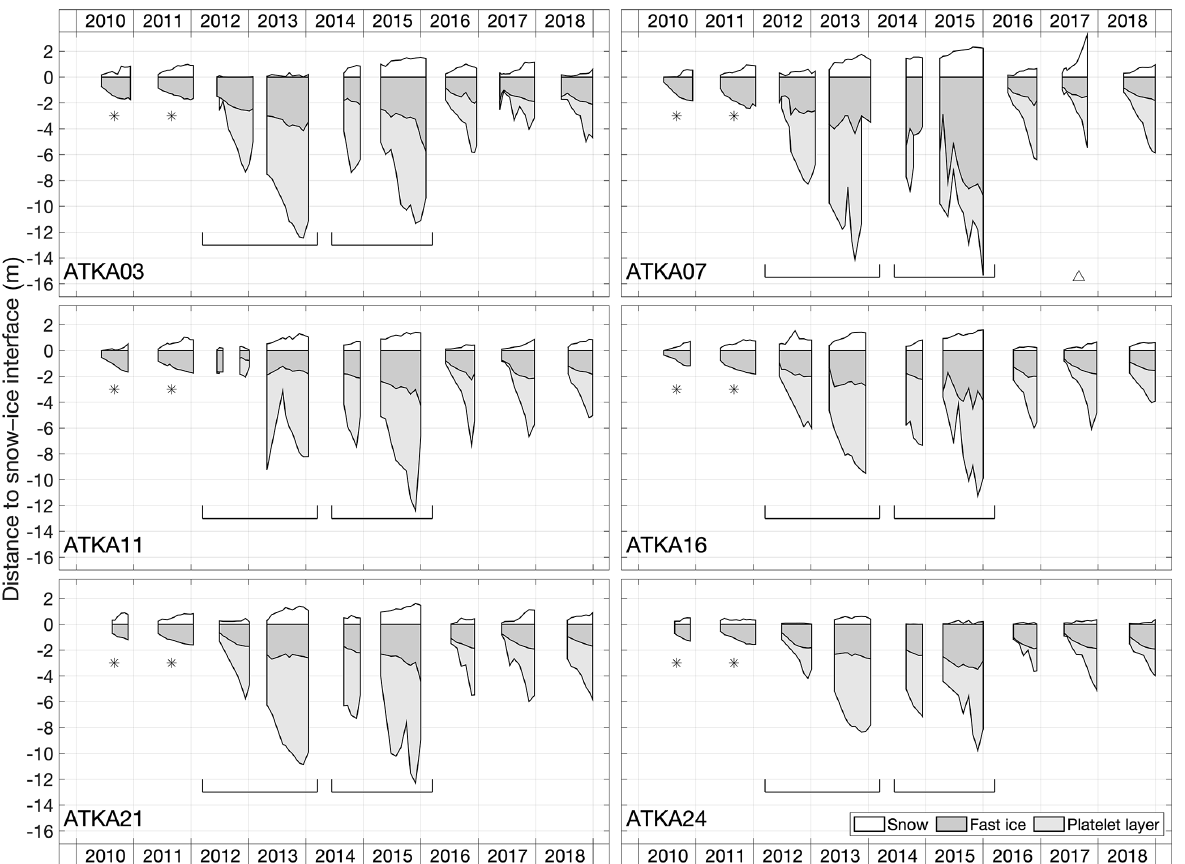
Figure 4. Time series of snow depth and fast-ice and platelet-layer thickness from borehole measurements along the standard transect for each ATKA sampling site (Fig. 1) for the time period from 2010 to 2018. Note in 2010 and 2011, the platelet-layer thickness was not measured (*). In 2012/2013 and 2014/2015 Atka Bay was blocked by icebergs, so the fast ice did not break up and turned into second-year ice instead. In 2017, a small iceberg in the vicinity of ATKA07 strongly influenced the snow measurements. The reference depth of 0m is the snow–ice interface. Table 1. Average annual maximum of snow depth and sea-ice and platelet-layer thickness, as well as freeboard (negative equals potential flooding) on the standard transect from borehole measurements for each ATKA sampling site (Fig. 1) for the time period from 2010 to 2018, excluding years of second-year ice due to blocking of the bay (i.e., 2013 and 2015). ATKA03 ATKA07 ATKA11 ATKA16 ATKA21 ATKA24 Snow depth in meters Ice thickness in meters Platelet-layer thickness in